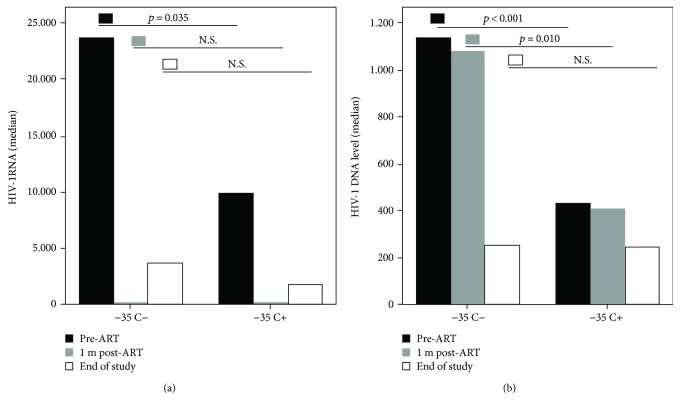
Graph showing the median of HIV-RNA viral load (a) and the median of HIV-1 DNA reservoirs (b) over time (pre-ART, one month post-ART, and at the end of the study) in the patients carrying the protective allele −35 C+ (genotypes CC + CT) and patients noncarrying −35 C (genotype TT); p values are indicated.